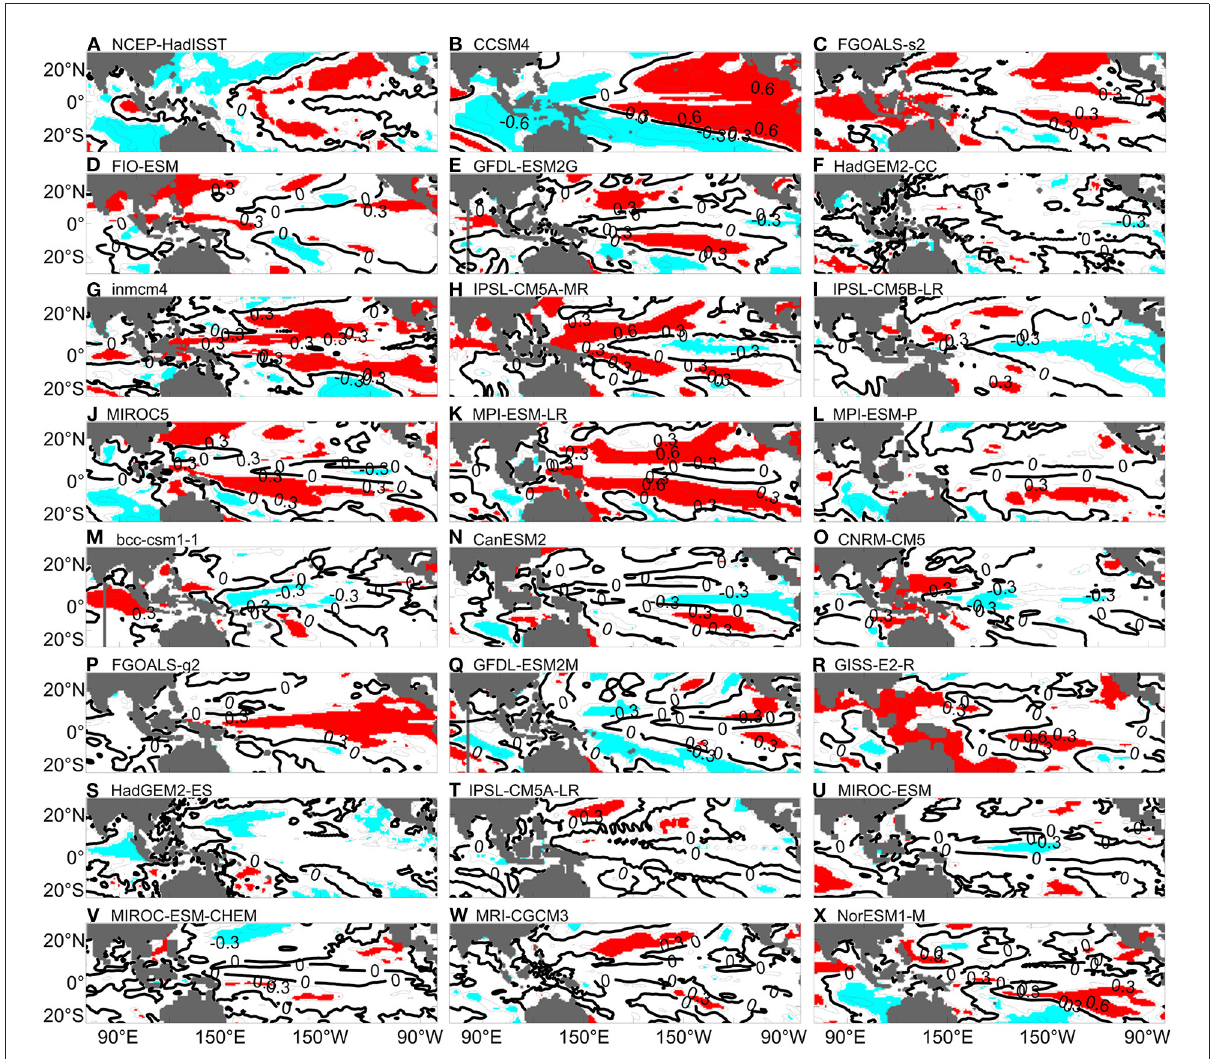
FIGURE9 Composite lag correlations between the WEP SZWA in the fall of Year 0 and tropical Indo-Pacific SSTA in the fall of Year + 1 in NCEP/HadISST and CMIP5 historical simulations during positive phases. The red and blue shading indicate the 95% significance level of positive and negative correlations, respectively. Index (A–X) refers to different CMIP5 model as listed in Supplementary Table